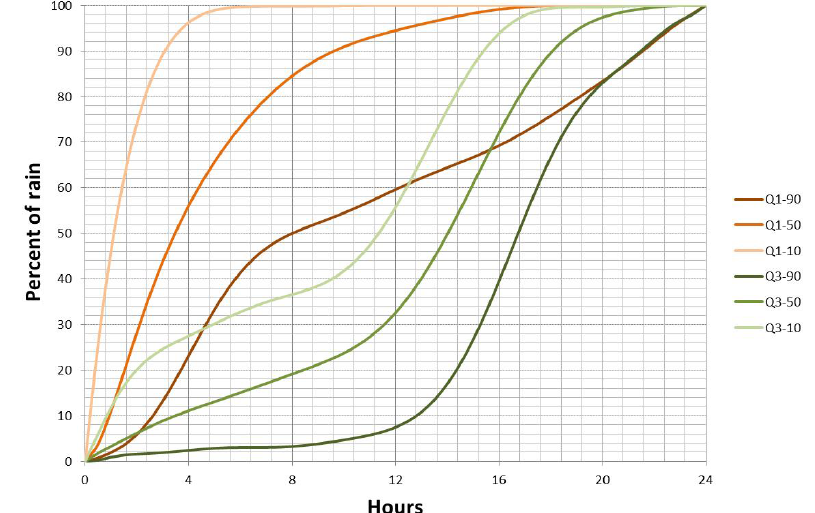
Figure 2. NOAA Atlas 14 temporal patterns used in the modeling.